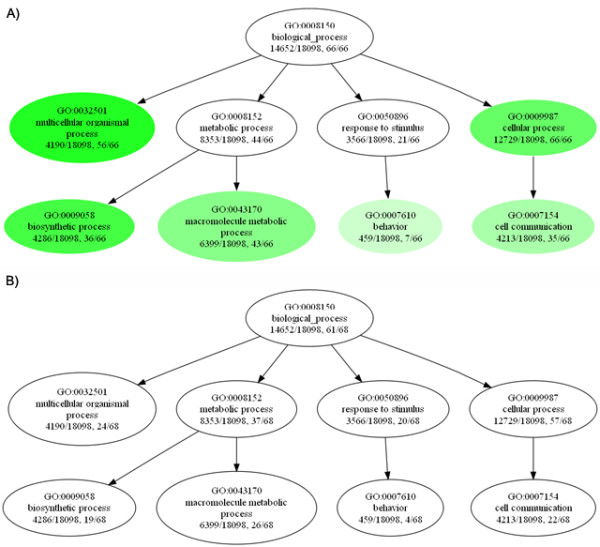
Gene Ontology enrichment for training and proposed Wnt/β-catenin pathway targets. Enriched nodes are colored in different intensities of green depending of adjusted p-values. Thus, more significant enrichment corresponds to the more intense green. First ratio corresponds to the proportion of GO terms in the human genome and the second ratio corresponds to the proportion of GO terms in the study group. A) GO terms enrichment for the known Wnt/β-catenin pathway target genes used as training group. B) GO terms enrichment in the same terms, for the proposed Wnt/β-catenin pathway target genes.